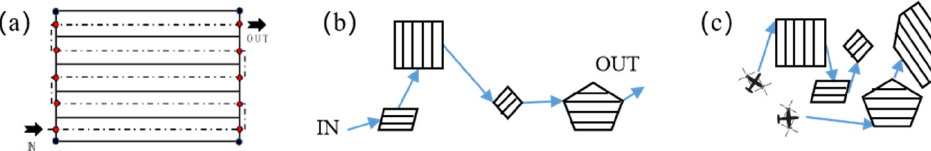
Figure 1. Coverage path planning: ( a ) single region; ( b ) multiple regions for single UAV; ( c ) multiple regions for multiple UAVs.